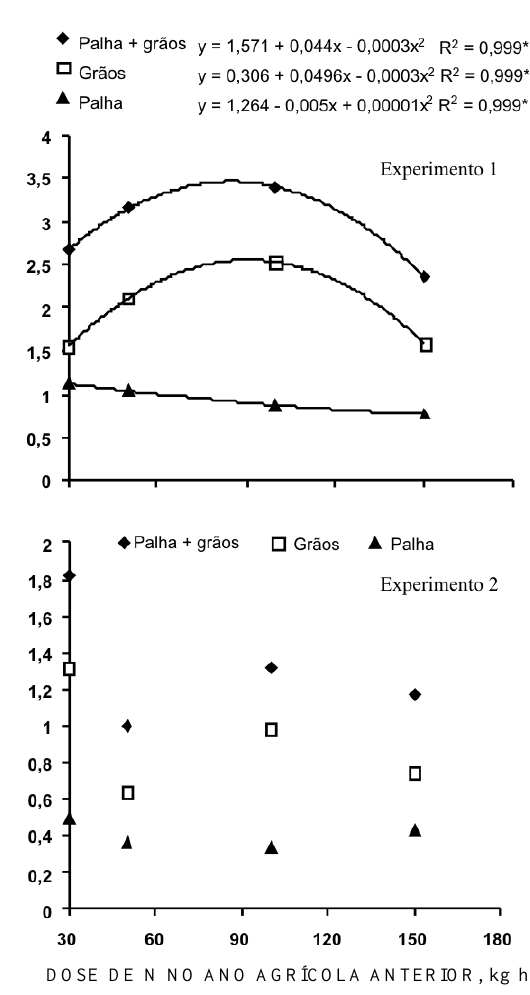
DOSE DE N NO ANO AGRÍCOLA ANTERIOR, kg ha Figura 3. Aproveitamento do N residual da uréia pelo milho (palha, grãos e palha + grãos) em 2002/03 (experimento 1) e 2003/04 (experimento 2), considerando a dose de N aplicada ao milho no ano agrícola antecedente.